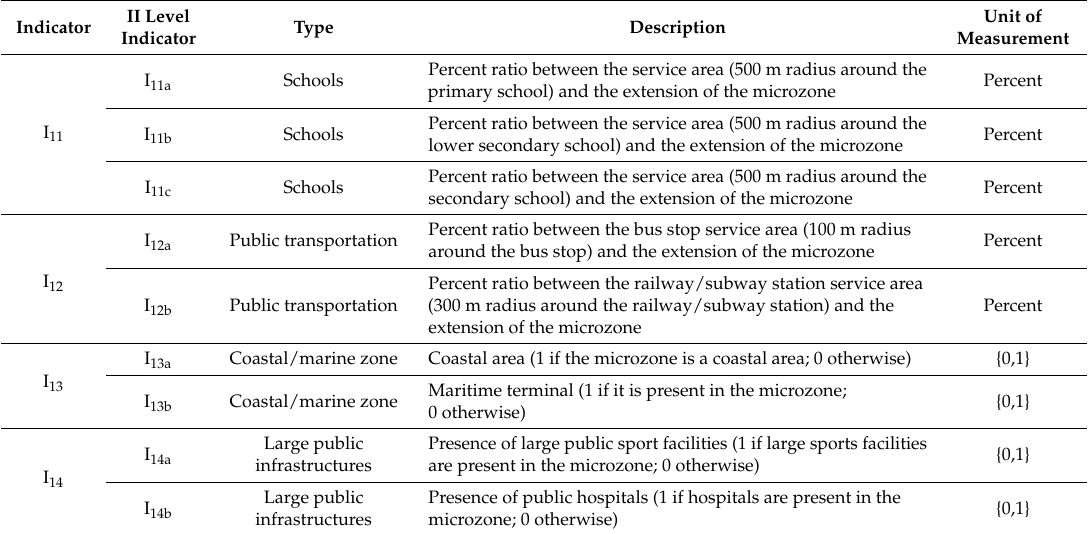
Table 5. II level indicators used to classify the microzones of the area of